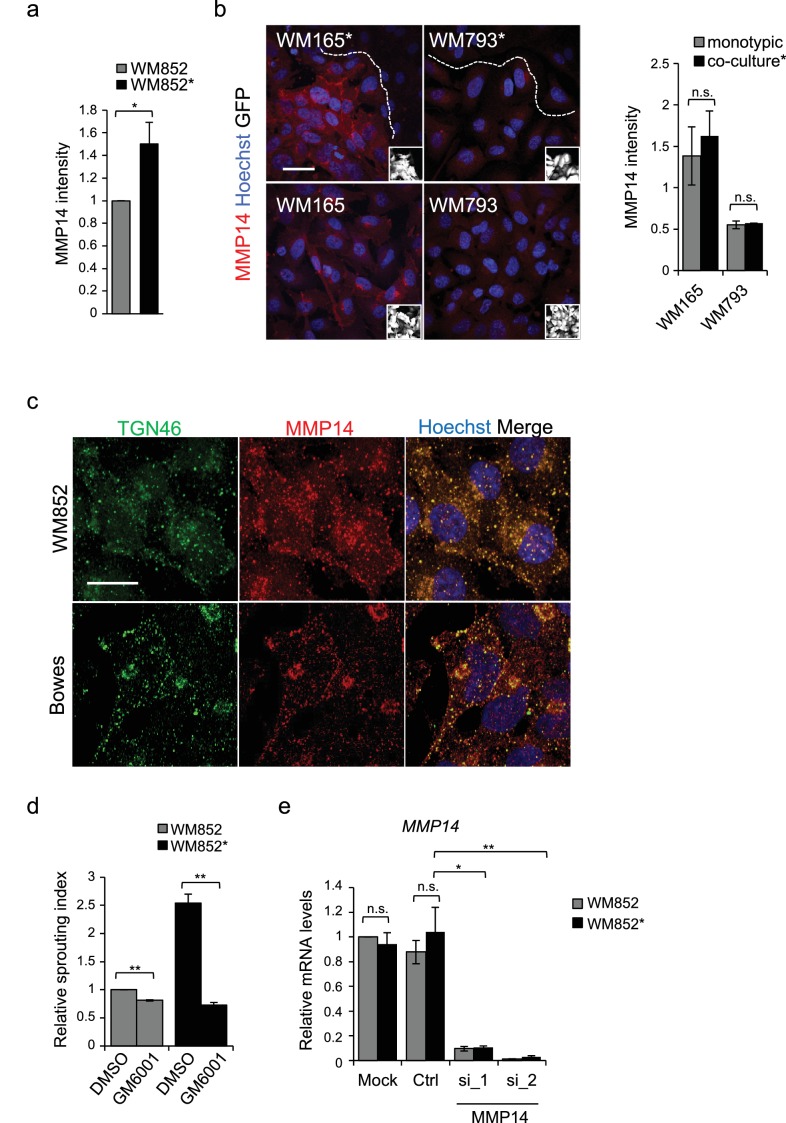
MMP14 levels increase and MMP14 activity is needed for 3D sprouting growth in LEC-primed metastatic melanoma.(a) Flow cytometry analysis of MMP14 levels in WM852 and WM852*. Mean fluorescence intensity normalized to WM852 is shown, error bars represent SD across three independent experiments; *: p<0.05. (b) Left panels: representative images of MMP14 staining (red) in WM165 and WM793 cells (GFP positive cells (white) in the insets) cultured in the presence (*, upper panels) or absence (bottom panels) of LECs. Nuclei were counterstained with Hoechst 33342. The dashed line indicates the LEC-melanoma (below the line) border. Scale bar = 50 µm. Right panel: quantification of MMP14 signal intensity for the indicated cell lines. Average of the intensity is shown from four images/condition from two independent experiments. More than 100 cells were always analysed per condition. Error bars indicate SD. n.s., non-significant (c) Confocal images of Bowes (upper panels) and WM852 (lower panels) stained with TGN46 (green) and MMP14 (red) antibodies, nuclei were counterstained with Hoechst 33342. Scale bar: 25 µm. (d) Relative sprouting index of WM852 and WM852* treated with the vehicle (DMSO) or panMMP inhibitor GM6001 for 48 hr during co-culture and after magnetic separation as well as during the 3D fibrin assay. Error bars indicate SEM; **: p<0.01. (e) MMP14 mRNA fold change in WM852 and WM852* treated with the indicated siRNAs for 72 hr; *: p<0.05; **: p<0.01. n.s., non-significant. Full size confocal images are available as source data 2.